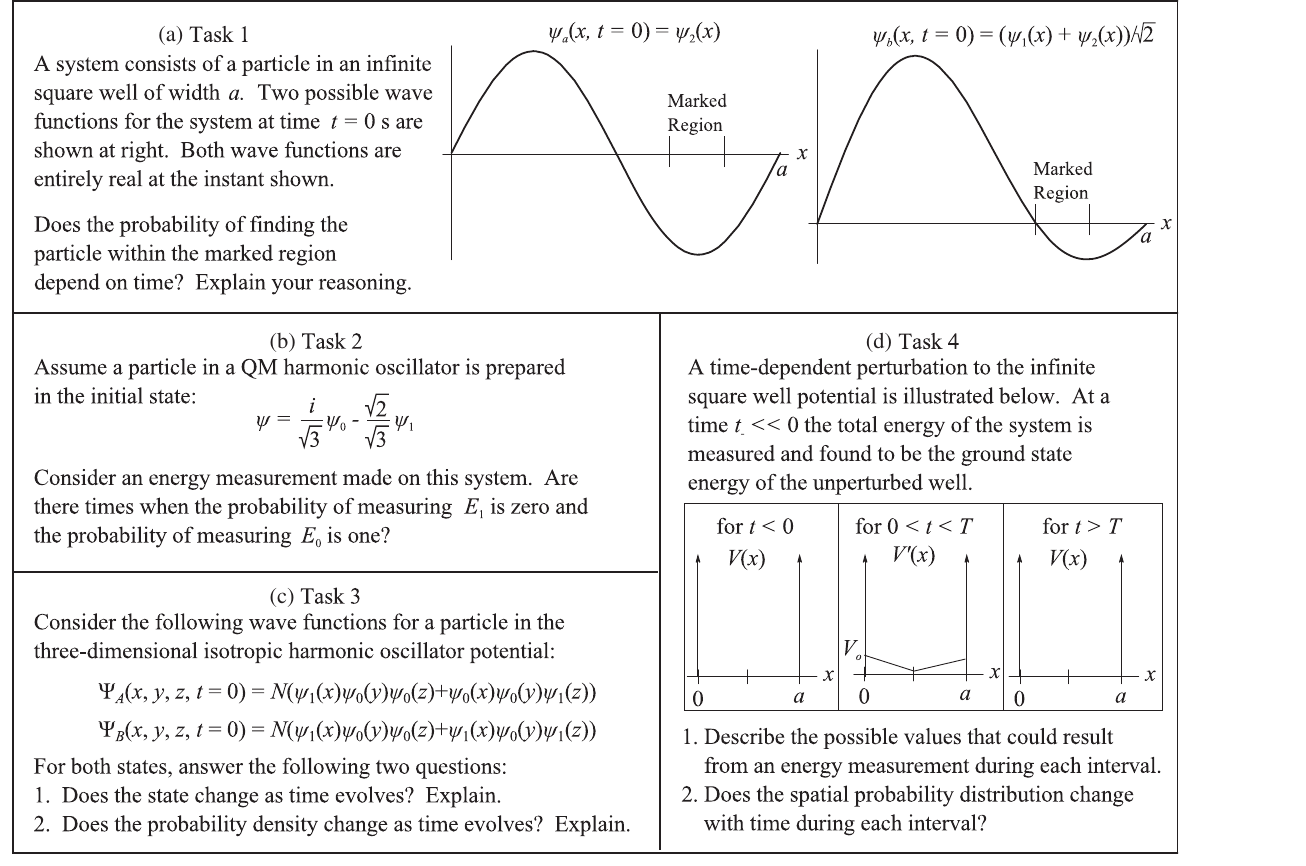
FIG. 1. Example versions of four tasks that were administered over the course of many years in a junior-level quantum mechanics course. (a) Task 1 and (b) task 2 were each administered to more than 400 students. (c) Task 3 was given to more than 250 students, and (d) task 4 was given to more than 200